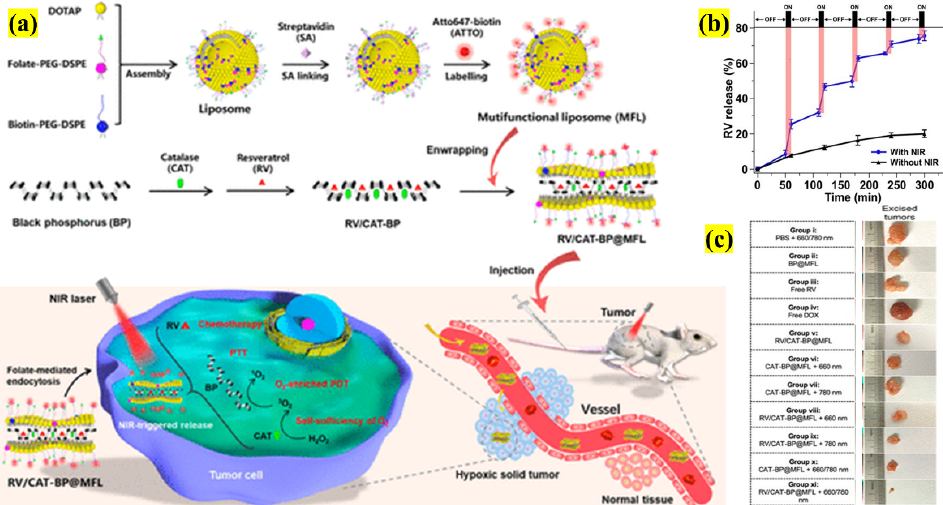
Figure 6. Schematic illustration depicting the ( a ) synthesis of RV/CAT functionalized NSs-liposome as a PT-responsive DDS and a PDT agent for cancer therapy, ( b ) RV release after 780 nm NIR laser trigger, ( c ) photographs of excised tumor tissues from representative mice of different groups after treatment (adapted with permission from Reference [37], ACS Applied Nano Materials, published by American Chemical Society, 2020).